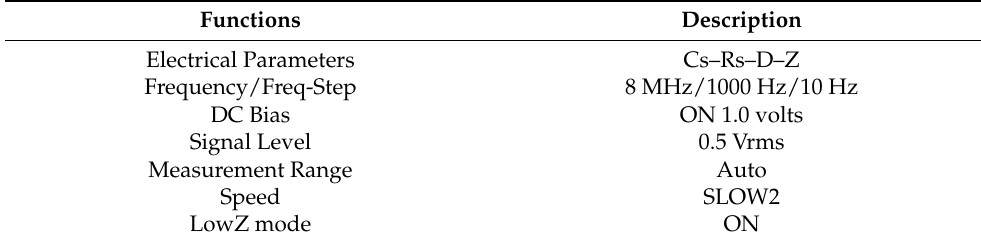
Figure 4. Overview of the experimental test-bed for the SMPS-AEC Data Acquisition. Table 2. Electrolytic Capacitor Experimental Test Conditions.